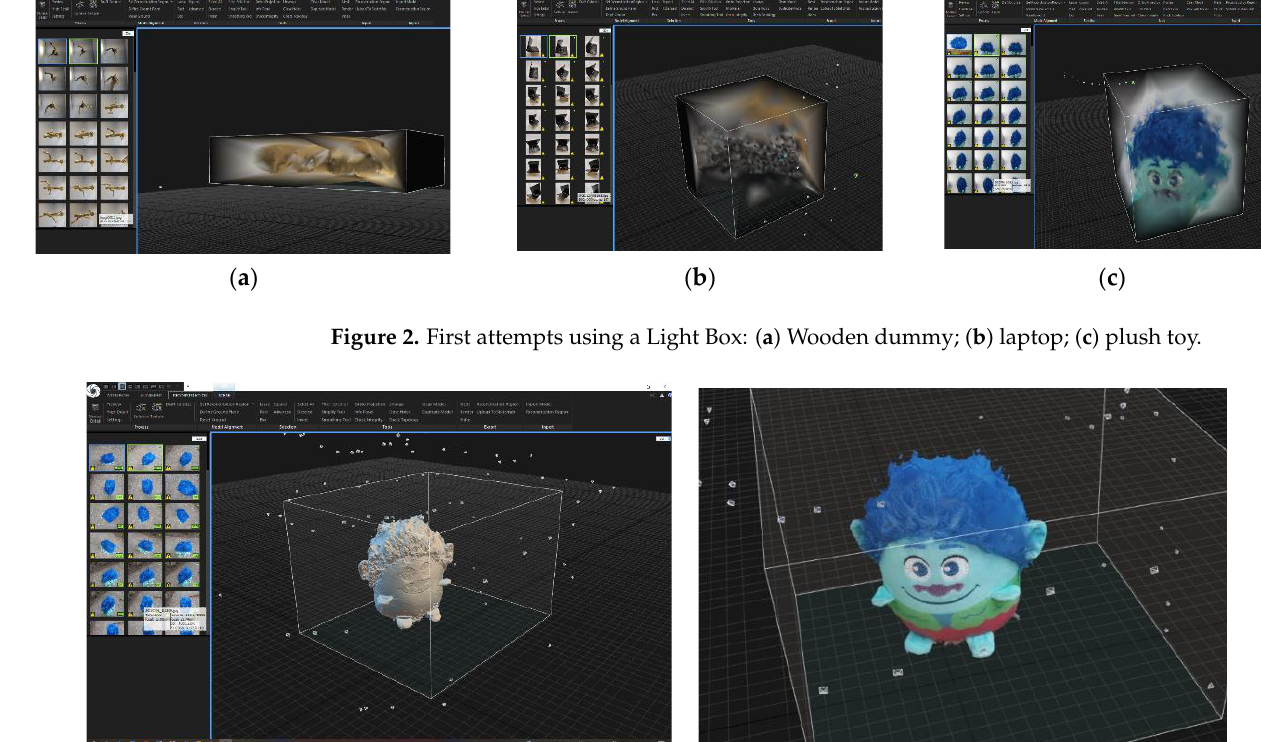
Figure 2. First attempts using a Light Box: ( a ) Wooden dummy; ( b ) laptop; ( c ) plush toy.